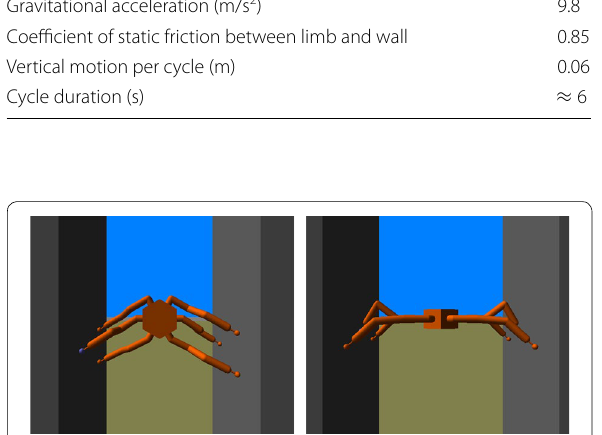
Fig. 5 Simulation outcomes using the proposed gait strategies Left figure is the vertical-body climbing gait. Right figure is the